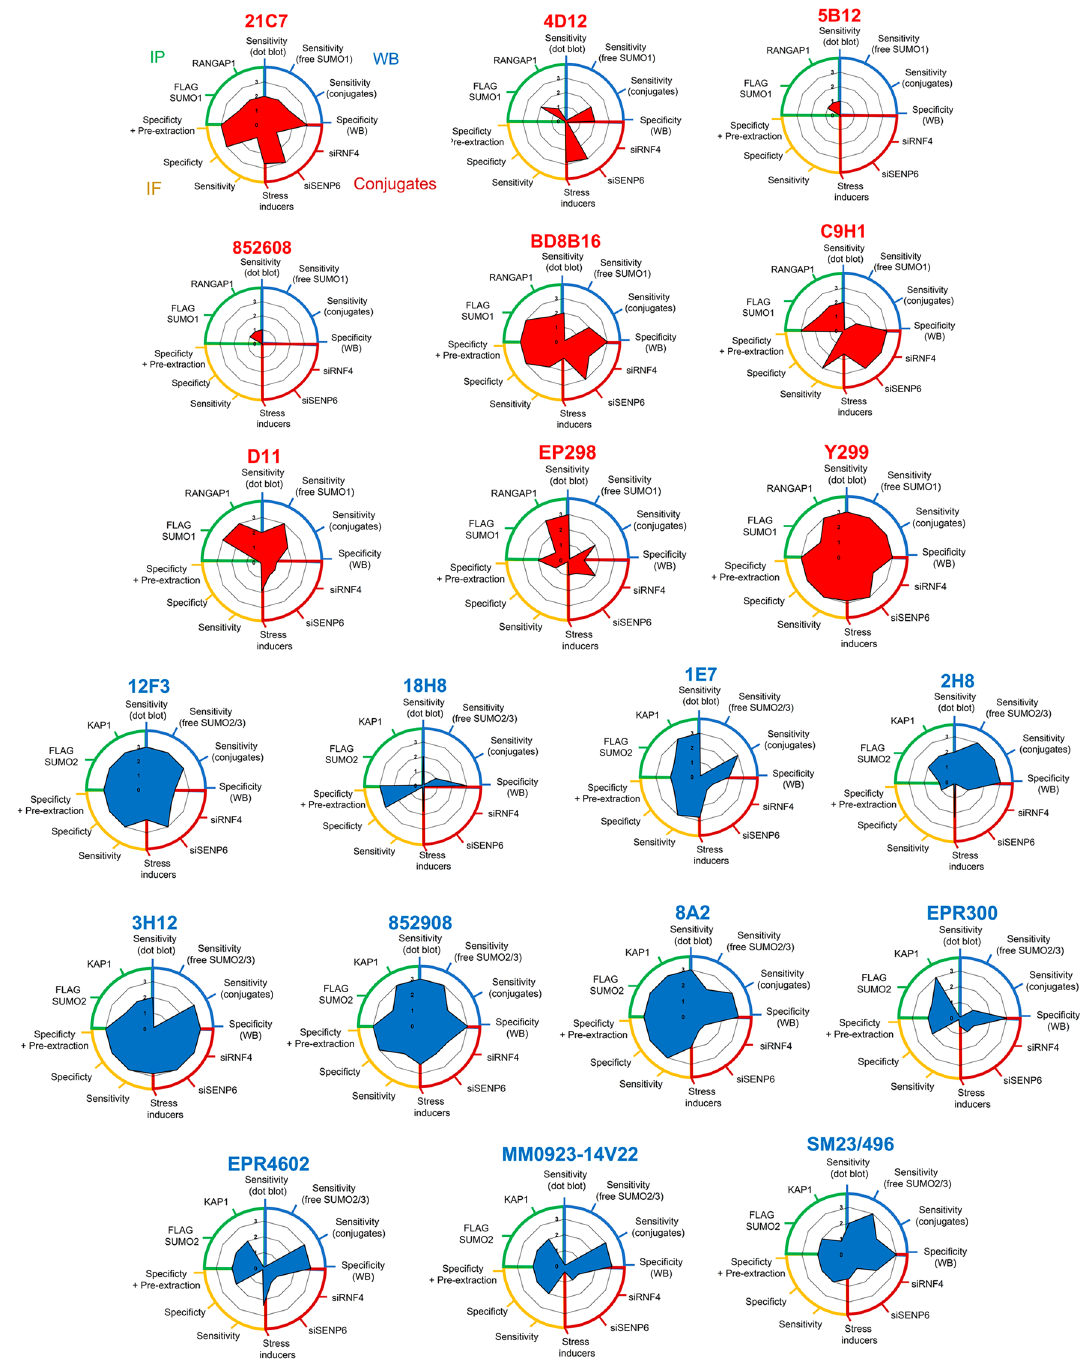
Figure 7. Summary of SUMO MAb performance across multiple applications. Radar plots of SUMO1 (Red) and SUMO2/3 (Blue) MAbs summarising the relative performance for each application tested. Performance is rated from 1 to 3 (low, medium or high), to criteria detailed in the relative quantification section of the materials and methods. Each application is grouped as follows in a clockwise orientation. Blue; performance by immunoblot; dot blot sensitivity, sensitivity (free SUMO), sensitivity (conjugates) and specificity (reduction in conjugates on siSUMO treatment). Red; change in conjugate intensity on siRNF4/siSENP6 treatment, change in conjugates (relative to untreated) for stress inducers summarised as a mean across all tested stresses to give an indication of the dynamics of SUMO conjugates detected following stress. Yellow; indirect immunofluorescence performance on fixed cells; sensitivity (signal intensity), specificity (reduction in the signal by siRNA treatment in both −/+ pre-extraction conditions). Green; immunoprecipitation performance against FLAG-SUMO and RANGAP-1 (SUMO1 MAbs) or KAP1 (SUMO2/3